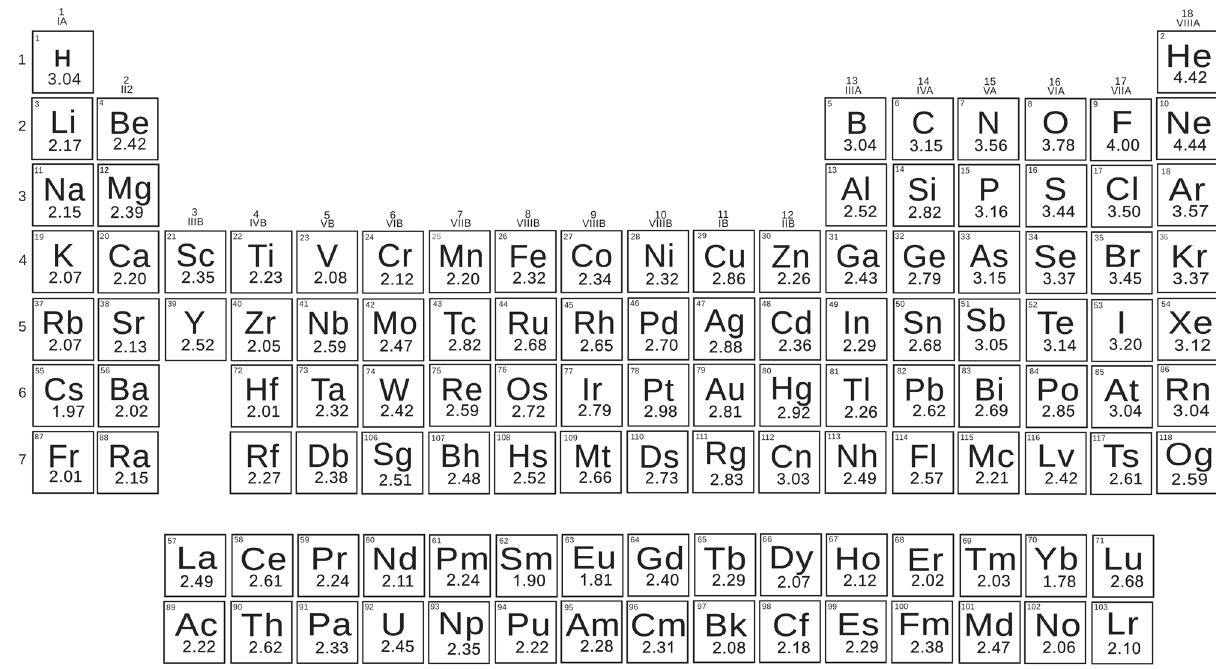
(cid:3) ð 1 þ Δ X 2 Þ (see Eq. 2), AB AB is the covalent dissociation energy modeled as the AB is the square of thermochemical electronegative difference between atoms A and B. AB